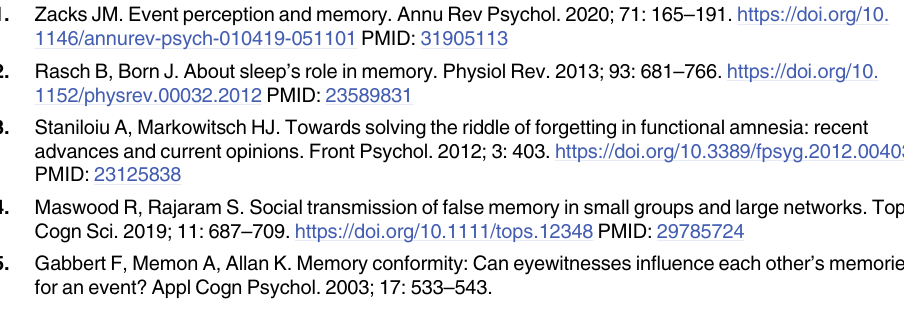
, 1 to a partic- 0